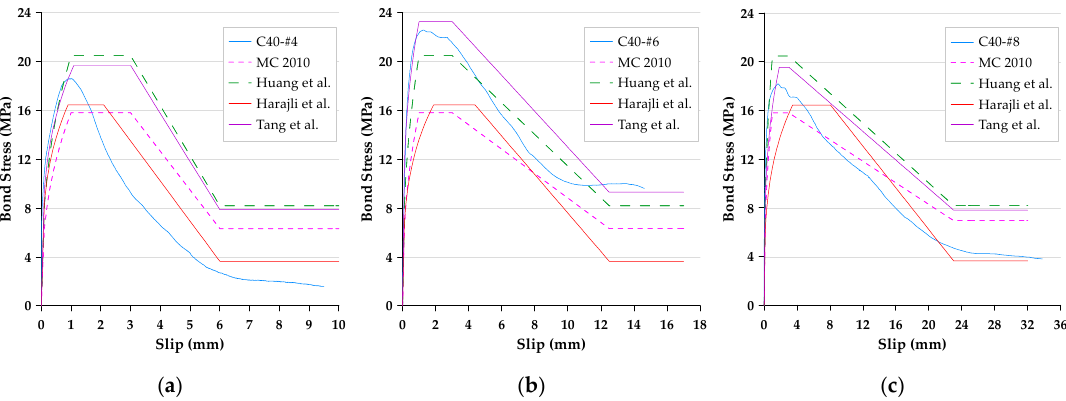
Figure 17. Comparison of the local bond stress–slip curve produced with different prediction models: ( a ) C20-#4, ( b ) C20-#6, and ( c ) C20-#8 (for specimens with low-strength concrete).